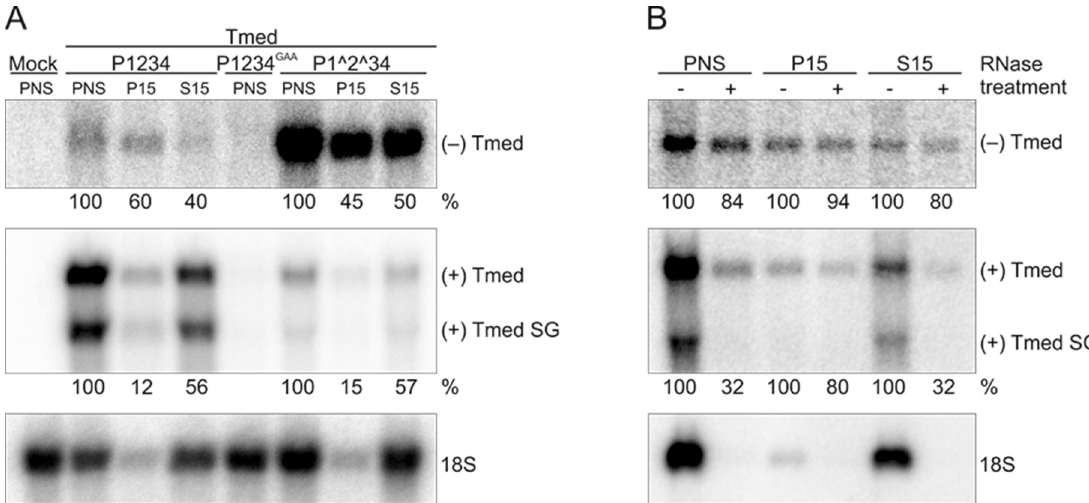
Figure 3. Distribution and stability of endogenous minus- and plus-strand RNA in P15 and S15 fractions prepared from transfected BSR cells. ( A ) PNS was prepared at 16 h post transfection,